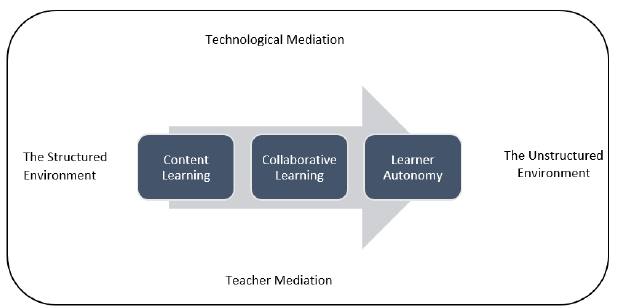
Figure 1. A technology-mediated pedagogical